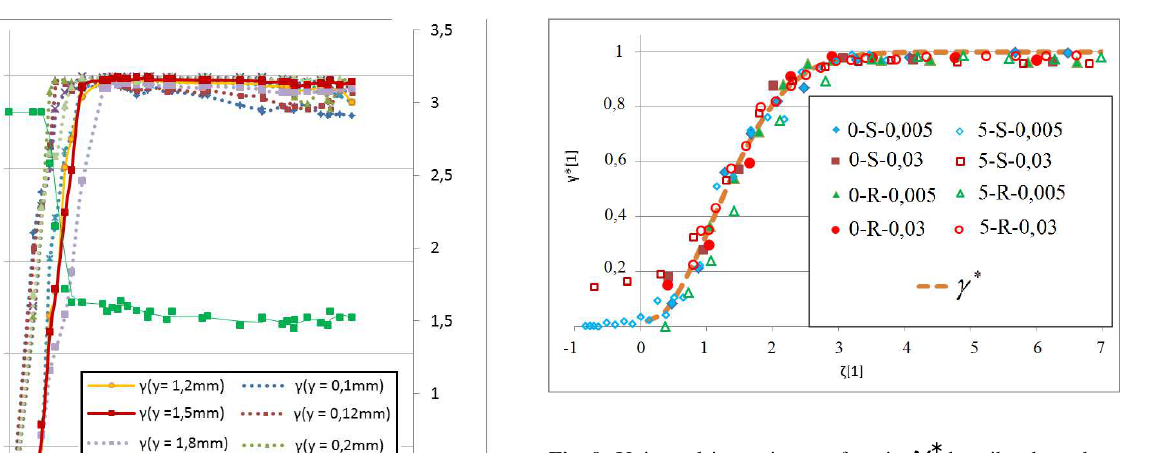
Fig. 9 . Universal intermittency function layer transition process, mcases without outer pressire gradient – influence of free stream turbulence and roughness of surface of the flat plate. Label explained in Tab.